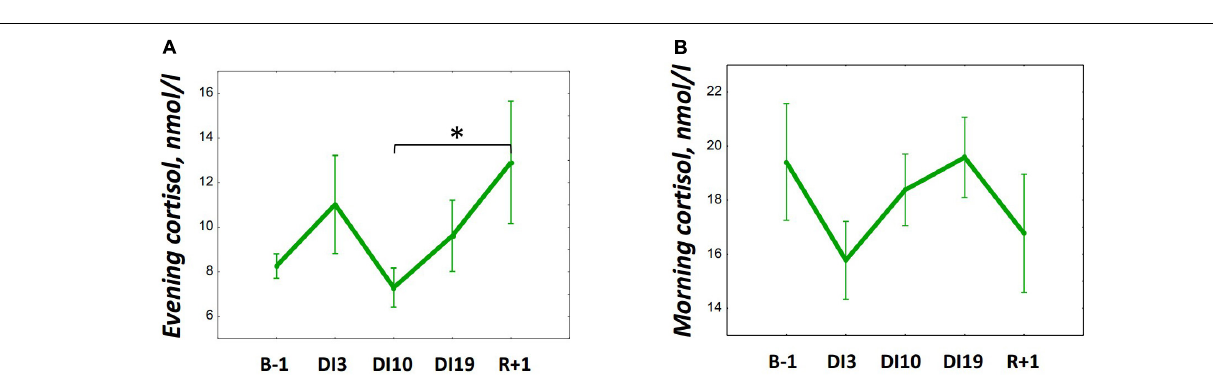
FIGURE 3 | Changes in the morning (A) and evening (B) cortisol during 21-day Dry Immersion and recovery. B-1, the day before dry immersion; DI3, DI10, and DI19, on the 3rd, 10th, and 19th days of dry immersion, respectively; R + 1, 1 day after the end of dry immersion. Intersession differences were examined using the post hoc Fisher LSD test. ∗ , represent significance p <